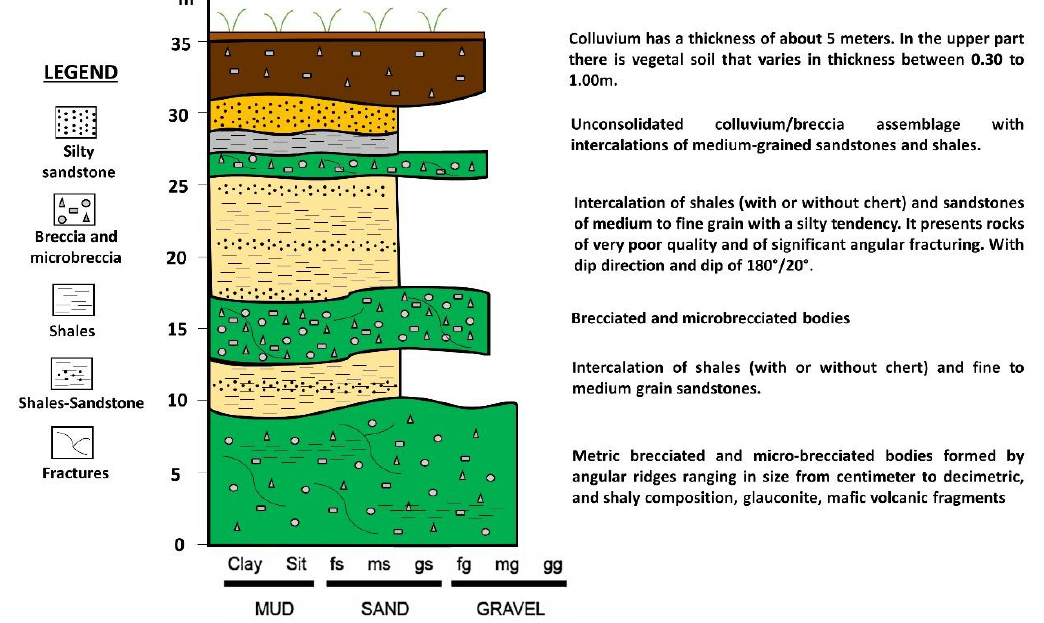
Figure 6. Slope stratigraphic column.